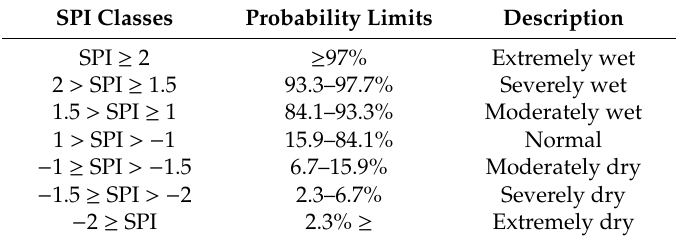
Table 2. Classification of the SPI’s values and corresponding probability limits